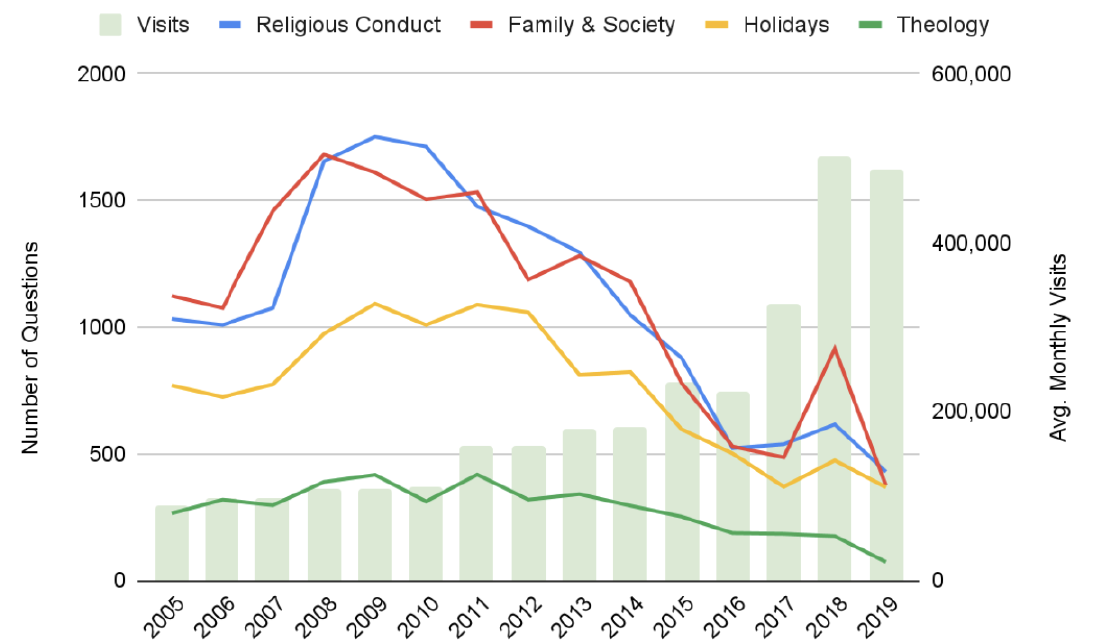
Figure 2. Total questions asked per year over average monthly site visits.